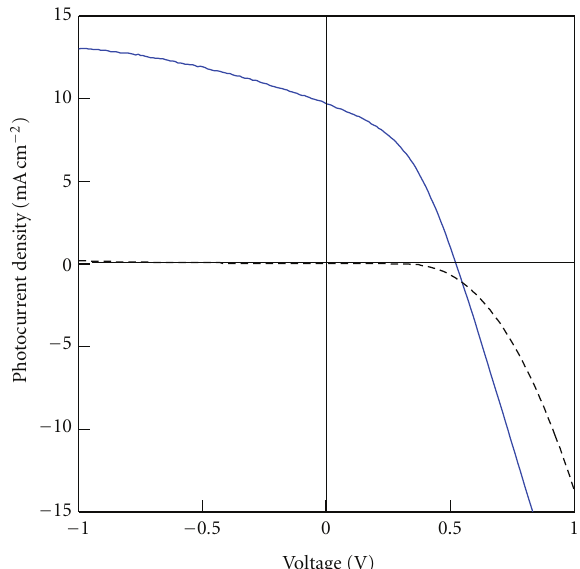
Figure 2: Photo (solid) and dark (dashed) I-V curves for the (cid:2) glass / FTO / TiO 2 / In 2 S 3 / Cu-In-S / Au (cid:3) solar cell. The cell size was 5mm × 5 mm, and the cell was irradiated with AM 1.5 (100 mWcm − 2 ) light.